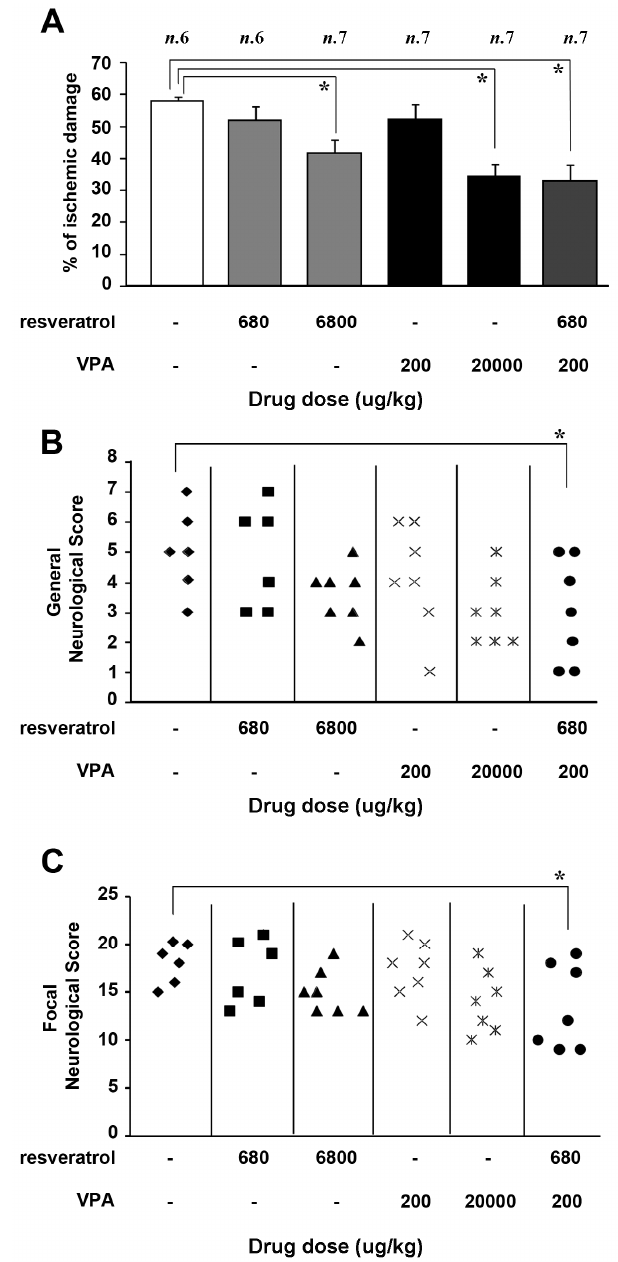
Figure 5. Effect of valproate (VPA), 200 and 20,000 µg/kg, and resveratrol, 680 and 6,800 µg/kg, administered individually or in combination (VPA 200 µg/kg + resveratrol 680 µg/kg) in mice subjected to 60 min of middle cerebral artery occlusion (MCAO). Drugs were administered 30 min after the end of the MCAO period and evaluation of brain damage was performed 24 h after ischemia induction. ( A ) Effect of drug administration on ischemic damage. Each column represented the mean ± s.e.m. of the percentage of the infarct volume compared with the ipsilateral hemisphere. * p < 0.05 versus vehicle-treated group; ( B , C ) Effect of diverse doses of VPA and resveratrol, individually or in combination, on general and focal neurological scores, evaluated 24 h after the ischemia induction. * p < 0.05 versus vehicle-treated animals.